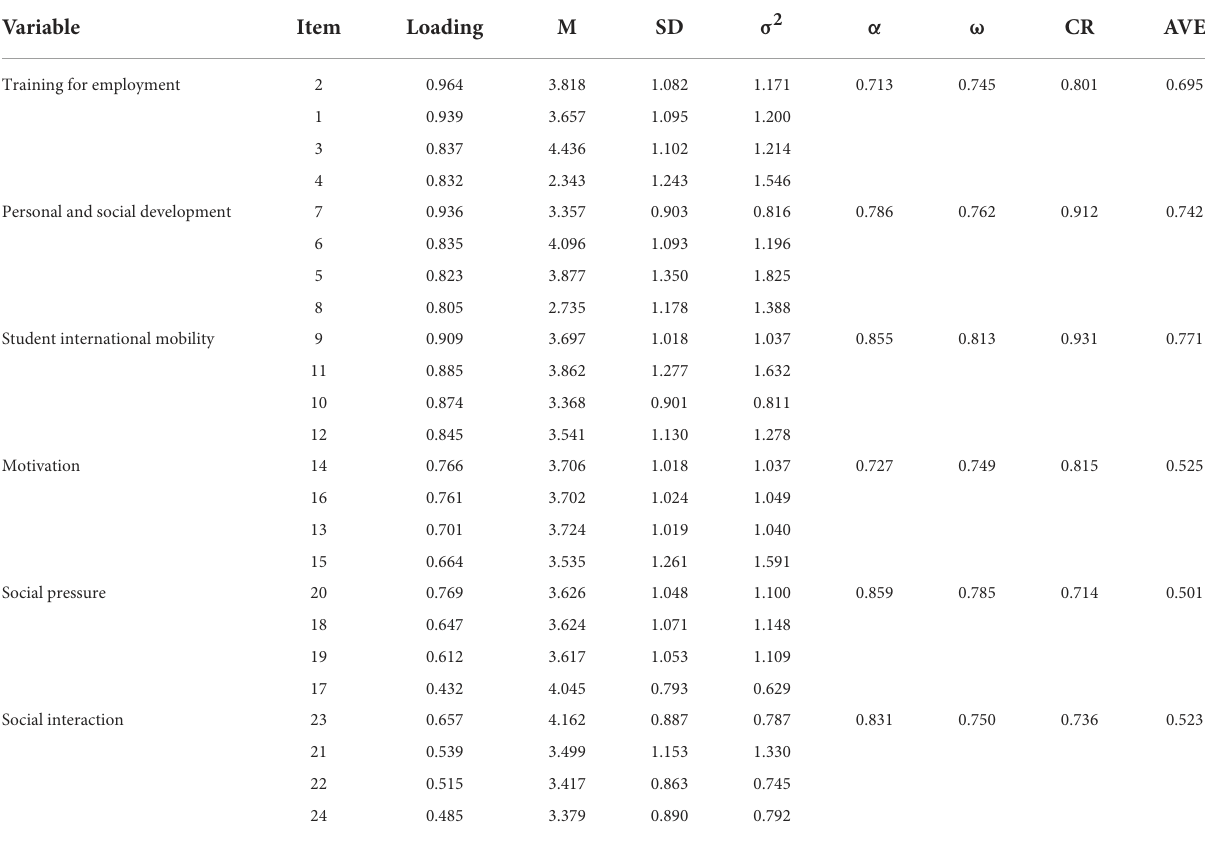
TABLE 2 Descriptive statistics and questionnaire validation.